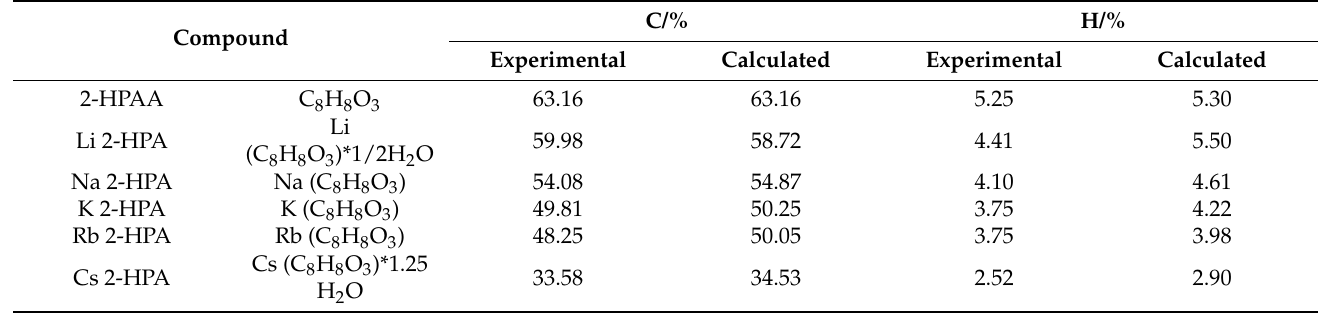
Table 5. The elemental analysis data of 2-HPAA and its alkali metal